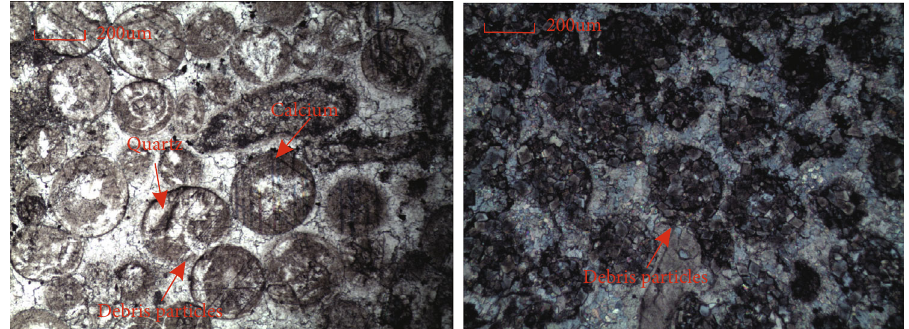
Figure 2: Micrograph of siltstone.